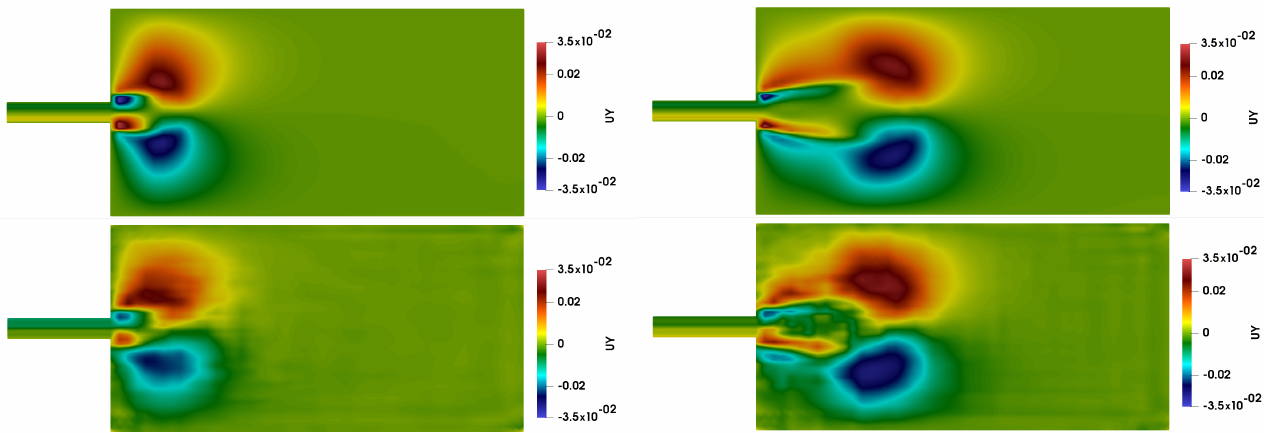
Figure 9. (Data-targeted VAE) On the top, the high-fidelity second component of the velocity fields for the two time steps 499 and 998. On the bottom, the decoder outputs for the two time steps 499 and 998 at the final 4000-th epoch of the training phase.